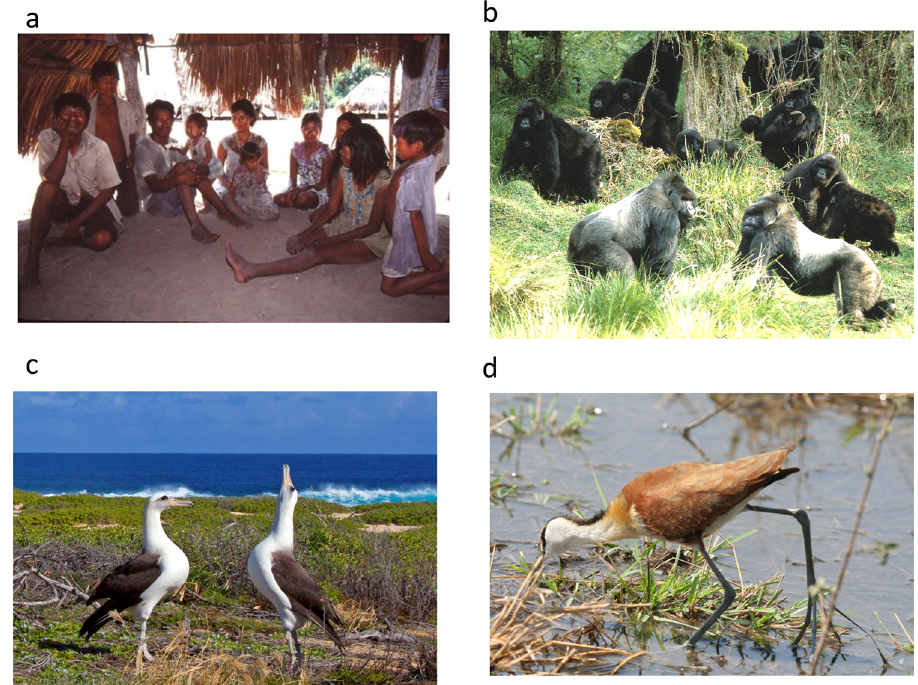
Fig. 4 Adult sex ratio variation and its implications for mating systems. a Small populations, such as human hunter-gatherers, are particularly susceptible to variation in partner availability which can result in fl exible, yet fragile, pair-bonds (e.g., Savanna Pumé, credit: R.D. Greaves) 12 ; b polygyny and male size dimorphism are common among species with female excess (e.g., mountain gorilla, credit: A. H. Harcourt) 47 ; c monogamy and biparental care are characteristic of even sex ratios and slight male excess across many species (e.g., Laysan albatross, credit: A. Badyaev) 111 ; d as male-bias in the adult sex ratio becomes even more dramatic, polyandry, female-biased sexual dimorphism and sex-role reversal are common (e.g., African jacana, credit: T. Székely) 110